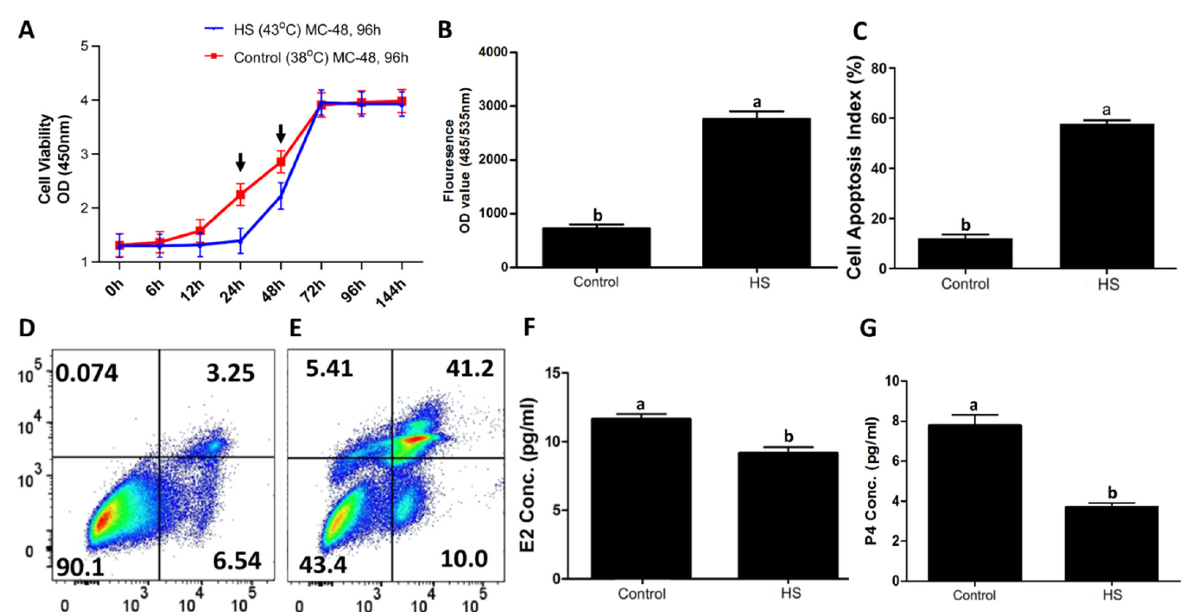
Figure 1. In vitro heat stress (43 ◦ C for 2 h) versus the control (38 ◦ C) treatment decreased cell viability, increased intracellular ROS accumulation, increased the incidence of apoptosis, and decreased the estrogen (E2) and progesterone (P4) syntheses in bovine granulosa cells [21,22]. Heat stress exposure decreased granulosa cell viability ( A ) Cell proliferation curves with mean optical densities (ODs) were plotted against different recovery time points in hours (h) for both groups. Heat stress exposure increased intracellular ROS accumulation in granulosa cells ( B ) fluorocolorimetric OD values of ROS in cells are shown ( B ). Heat stress exposure elevated granulosa cell apoptosis and decreased viability ( C ) Flow cytometry analysis of granulosa cells cultured under heat stress ( E ) and the corresponding control ( D ) are presented. Heat stress exposure decreased E2 ( F ) and P4 ( G ) synthesis by granulosa cells ( A ). All data are presented as means ± S.E. Time points (24 and 48 h) with black arrow signs above them are significantly ( p < 0.05) different ( A ), while “MC” refers to the culture media change at the given hours ( A ). Means without common letters (a, b) are significantly different ( p <